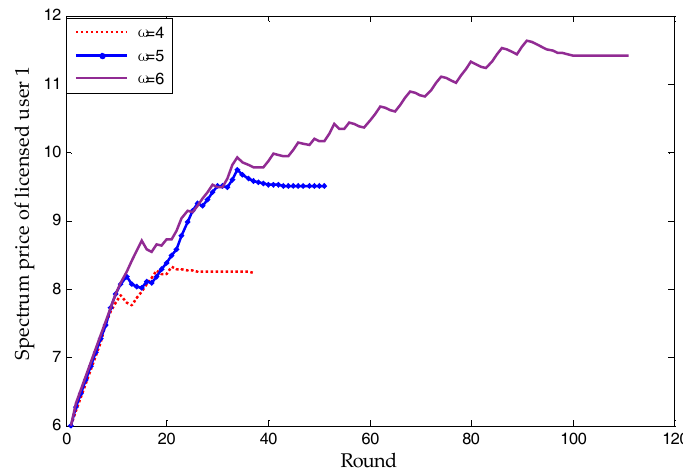
Figure 10. The relationship between spectrum price and ω